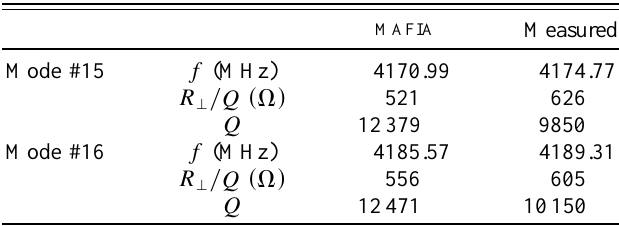
TABLE I. Transverse shunt impedance (transit time not